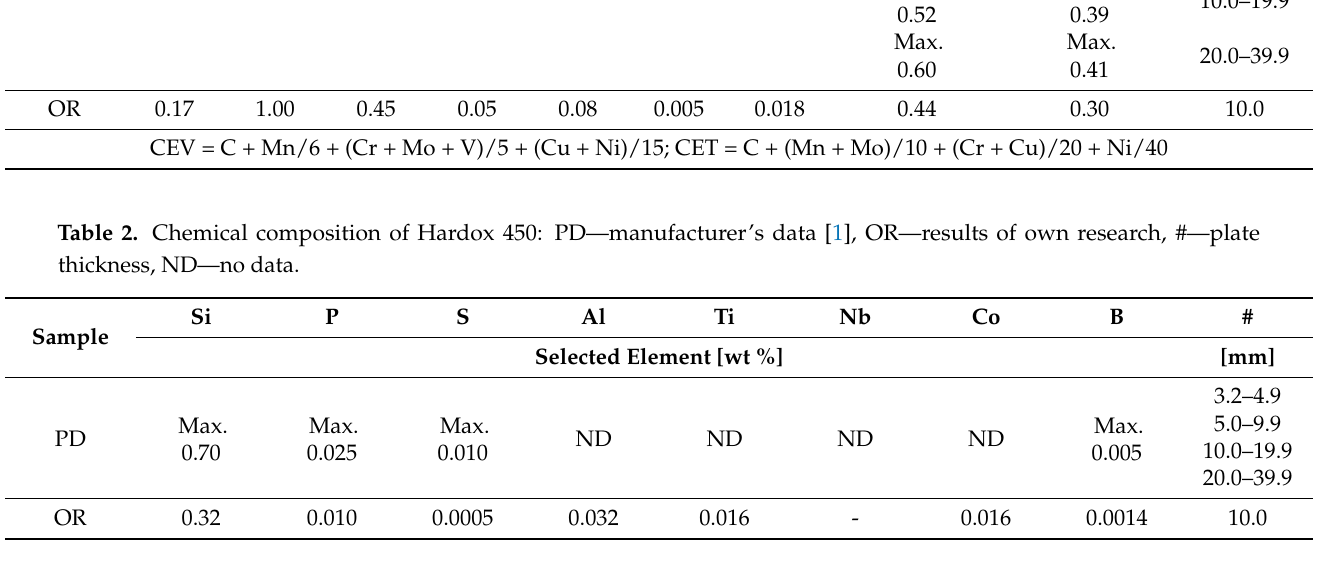
Table 3. Mechanical properties of Hardox 450 for samples taken longitudinally to the thermo-plastic processing direction: D—delivery state, PD—manufacturer’s and distributor’s data for sheet thickness 3.2–80.0 mm [1,2], OR—own test results for samples taken from sheet thickness 30.0 mm, reported in [4], Q900-Q1200—samples hardened after austenitising